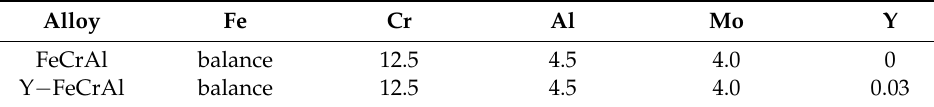
Table 1. Chemical compositions (wt.%) of FeCrAl